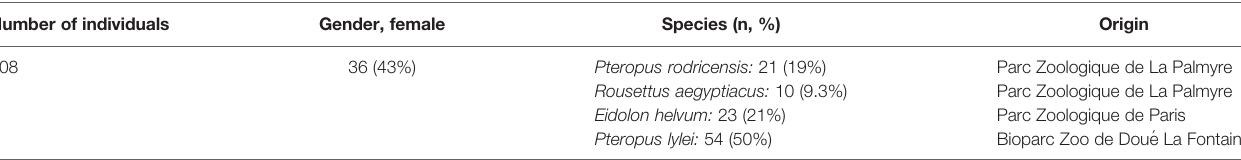
Number of individuals, gender, species and origins for the bat cohort. Data are shown as the n